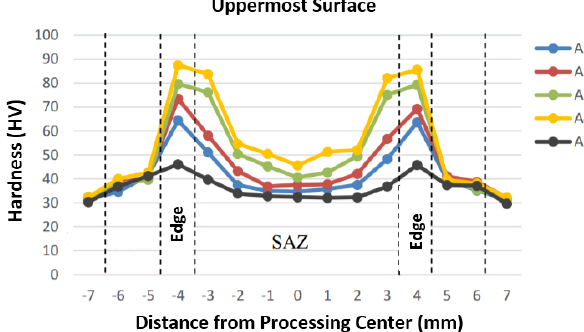
Figure 7: Vickers micro hardness at uppermost surface of